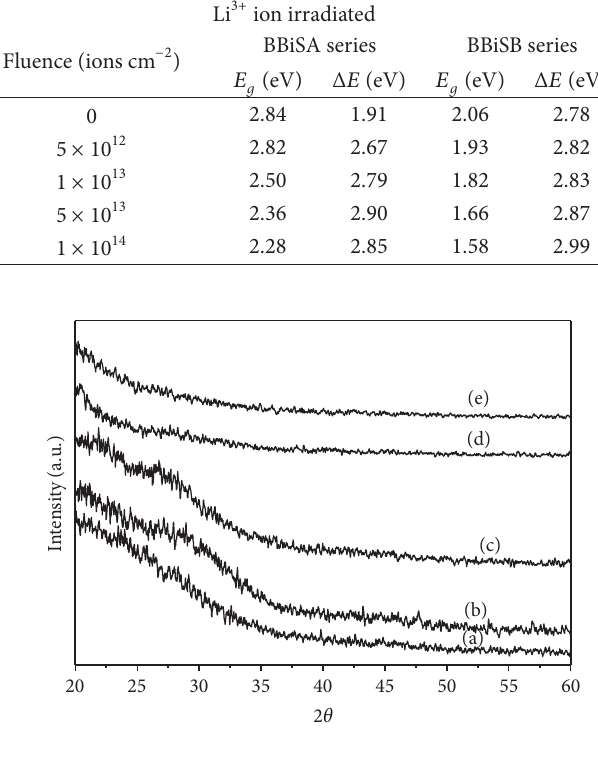
ion-irradiated F 2: e X-ray diffraction patterns of the Li 14+ glass thin �lms of BBiSA series: (a) unirradiated;